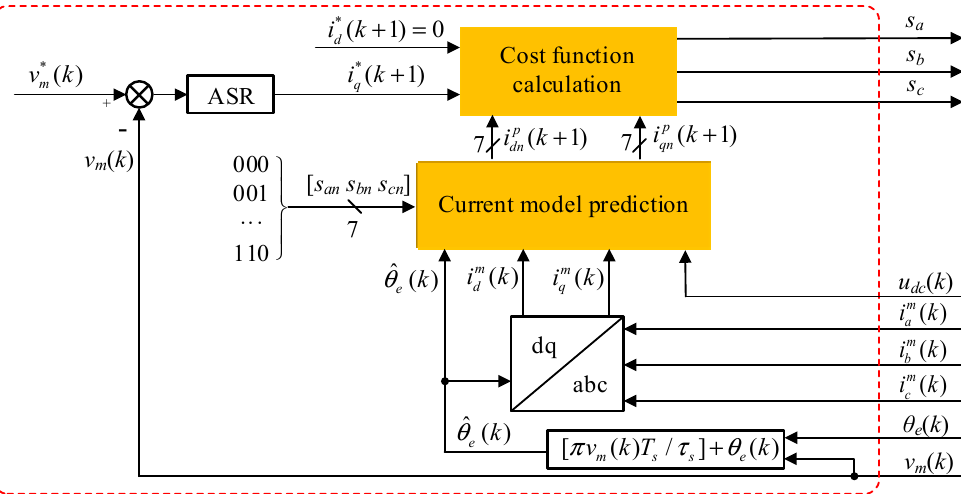
Figure 3. Model predictive current control (MPCC)-I for the PPMLM traction system.